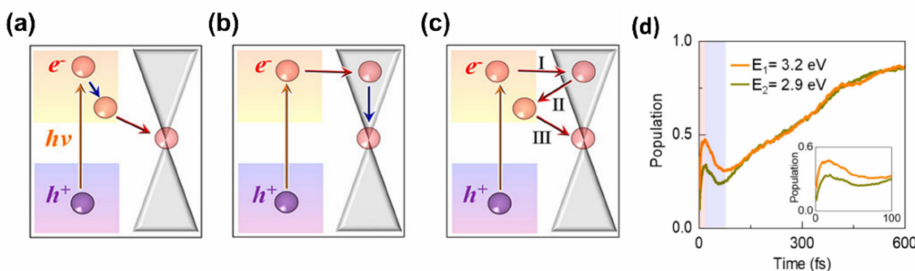
Figure 4. Schematic representation of the photoinduced hot carriers dynamics at MAPbI 3 /graphene interface: ( a ) the hot electrons in MAPbI 3 relax to the conduction band minimum (CBM) and then transfer to graphene (pathway 1), ( b ) the hot electrons in MAPbI 3 diffuse to graphene and then relax to the Dirac point (pathway 2), ( c ) the hot electrons in MAPbI 3 follow a zigzag path between MAPbI 3 and graphene. ( d ) Population at graphene of the hot electrons with energies of 2.9 and 3.2 eV above the Fermi level of the MAPbI 3 /graphene interface as a function of time after optical excitation. Figures adapted from ref. [66]. Copyright American Chemical